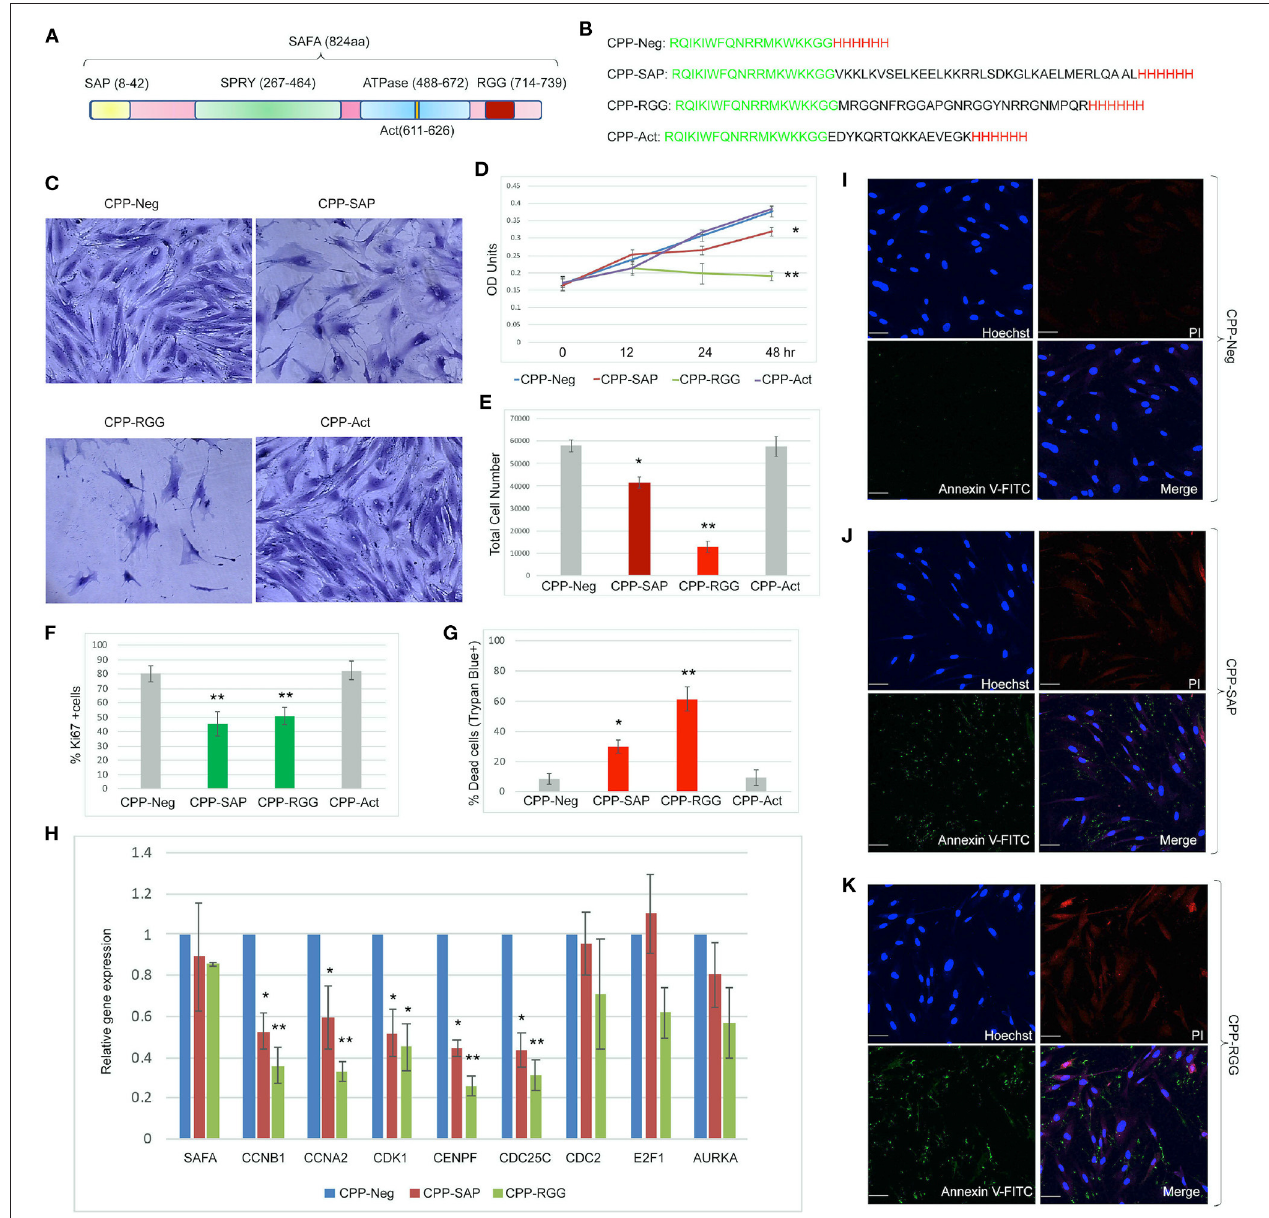
FIGURE 1 | Cell-penetrating SAFA-derived peptides reduce proliferation of primary human fibroblasts. (A) Schematic of SAFA protein domains. Numbers in the brackets indicate the amino acids in each domain. (B) Sequences of the cell-penetrating peptides CPP-Neg, CPP-SAP, CPP-RGG, and CPP-Act-His. The sequence of Penetratin is in green, his tag in red and SAFA domains in black. (C) Representative light microscopic images of crystal violet-stained human foreskin fibroblasts treated for 48h with 10 µ M concentration of SAFA-derived peptides (listed at top). (D) Crystal violet assay of HFFs treated with CPP-Neg, CPP-SAP, CPP-RGG, and CPP-Act peptides over the course of 48h. (E) Quantification of total cell number of HFFs after 24h of treatment. (F, G) Quantitation of Ki67 + cells (F) and -percent dead trypan blue stained cells (G) after 24h of peptide treatment. (H) qRT-PCR analysis of cell cycle gene transcripts in total RNA isolated after 24h of peptide treatment. (I–K) Representative immunofluorescence images of Annexin V/PI stained HFFs after 24h treatment [ (I) , CPP-Neg; (J) , CPP-SAP; (K) , CPP-RGG]. Individual channels (Hoechst = Blue, Annexin V = Green, PI = Red) and merged images are shown. Scale bar, 50 µ m. Error bars represent standard deviation. * p < 0.05, ** p < 0.01 relative to